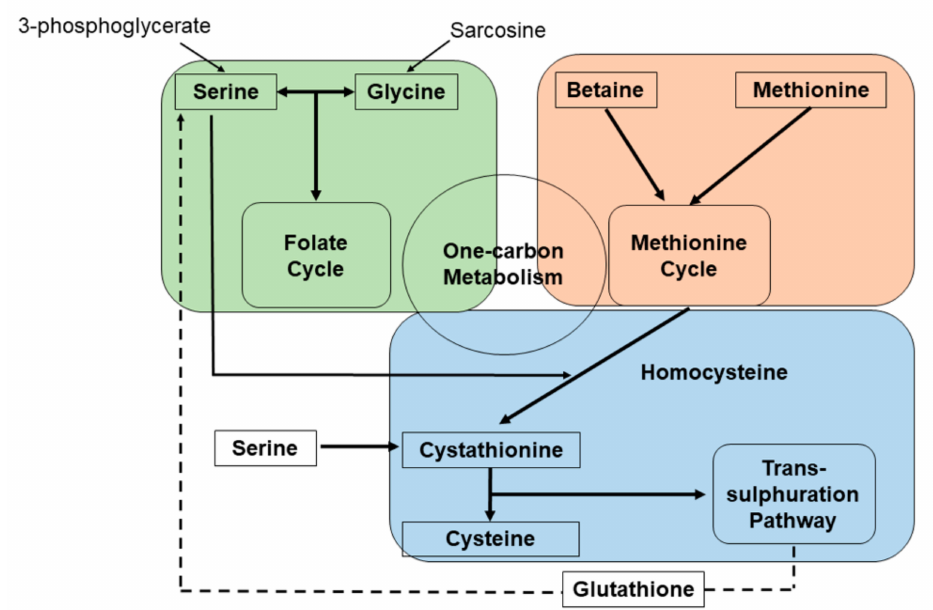
Figure 1. Schematic diagram of serine and glycine metabolism